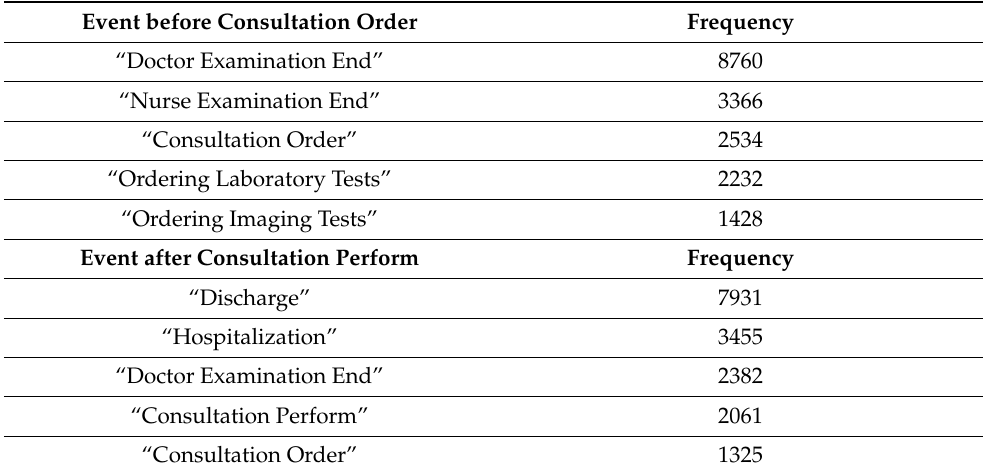
Table 5. Top five most common events that happened before ‘Consultation Order’ and after ‘Consul- tation